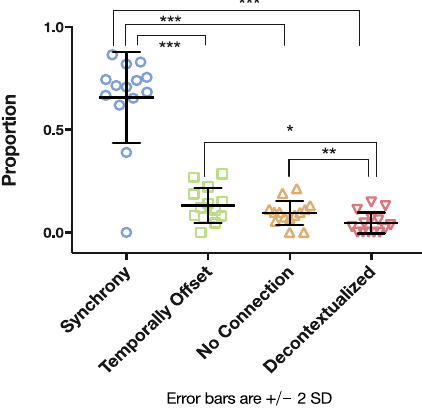
Figure 7. Verb–action categories (* p < 0.05; ** p < 0.01; *** p < 0.001).